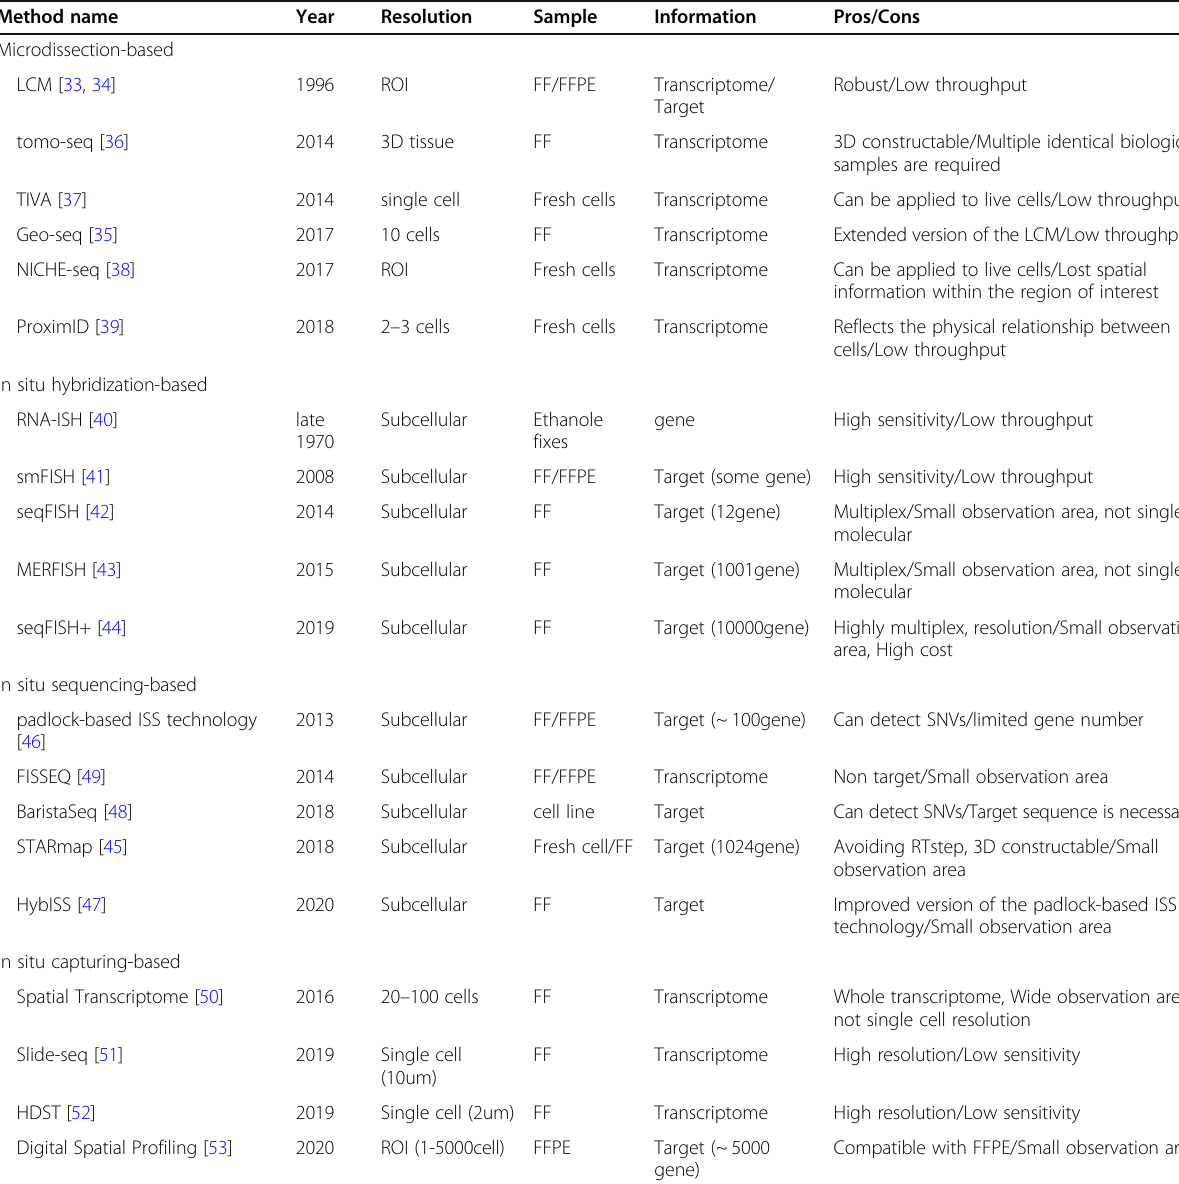
Table 2 Comparison of ST seq technologies Method